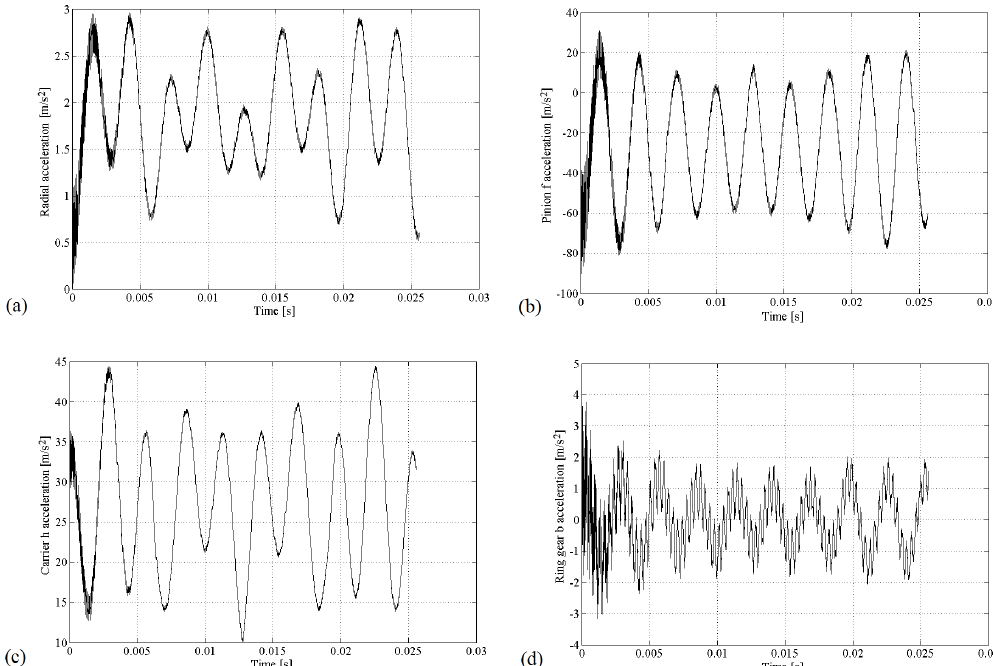
Figure 4. Acceleration diagrams for c 1 = 1 . 67 × 10 10 Nm − 1 , c 2 = 1 . 56 × 10 10 Nm − 1 , k 1 = 3200Nsm − 1 , and k 2 = 2400Nsm − 1 : (a) y 1 direction, (b) θ h direction, (c) θ f direction, and (d) θ b direction.